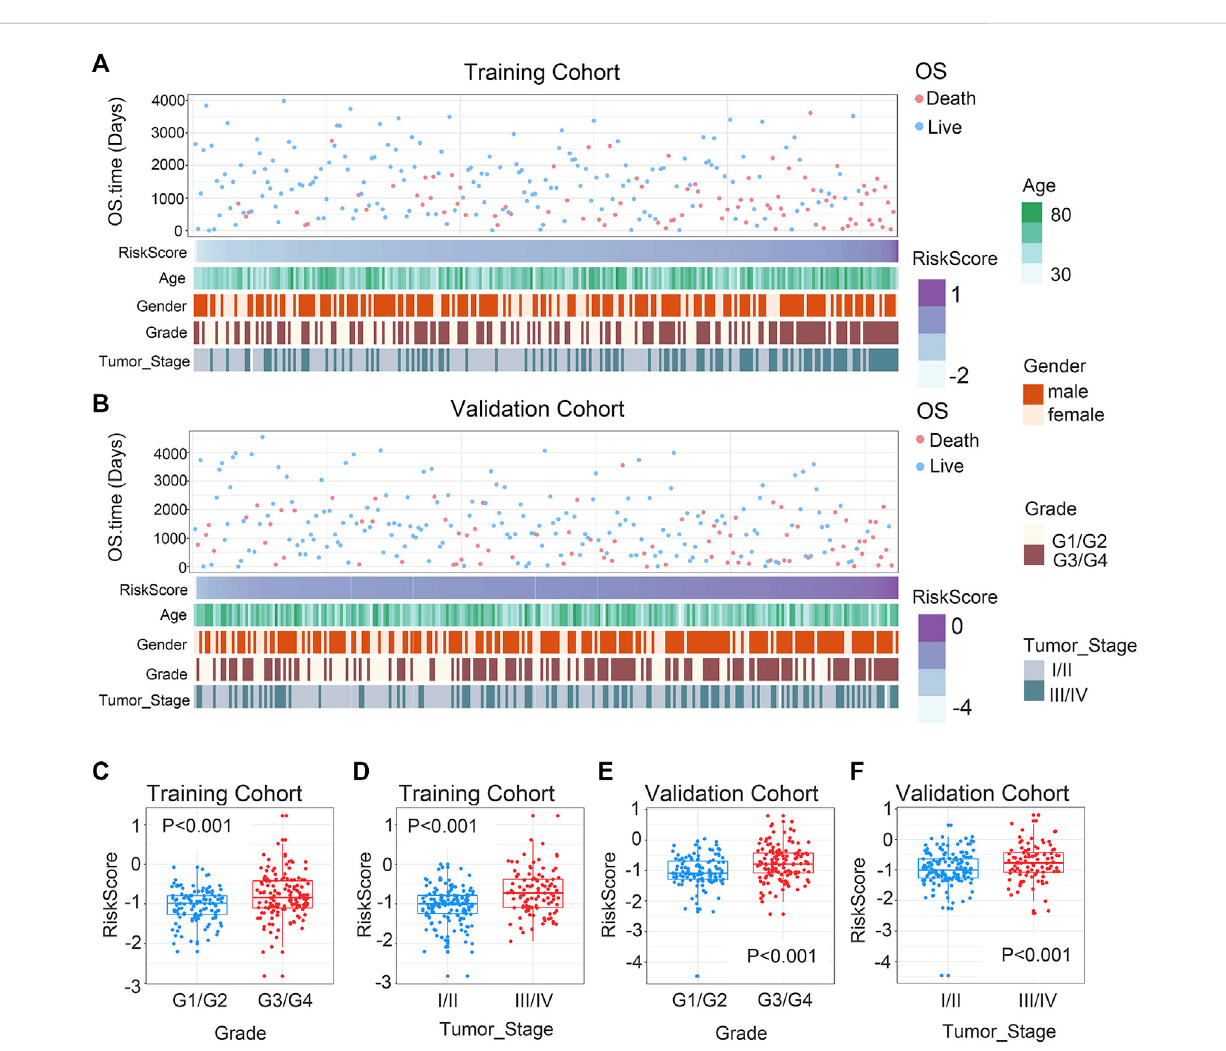
FIGURE 2 Association between chemokine-based gene signature and clinical features in ccRCC. (A) Correlation of riskscore and clinicopathological characteristics of patients in the training cohort. (B) Correlation of riskscore and clinicopathological characteristics of patients in the validation cohort. (C,E) In the training andvalidationcohorts, riskscoreconsiderably riseathigher-gradeccRCC. (D,F) Inthetraining andvalidationcohorts, riskscore considerably rise at higher-stage ccRCC. The signi fi cance of the difference was tested with Wilcoxon